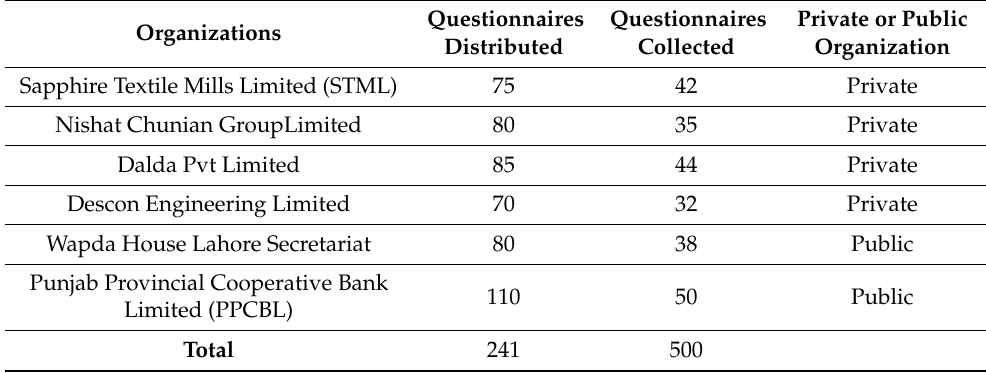
Table 1. Number of questionnaires distributed and collected.